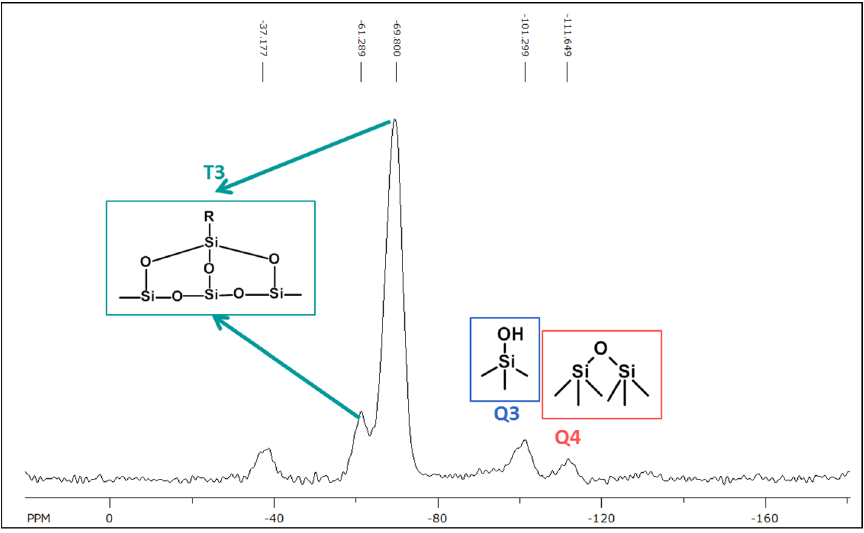
Figure 4. Solid state CP MAS 29 Si NMR of the SNAP/PIL hybrid material.